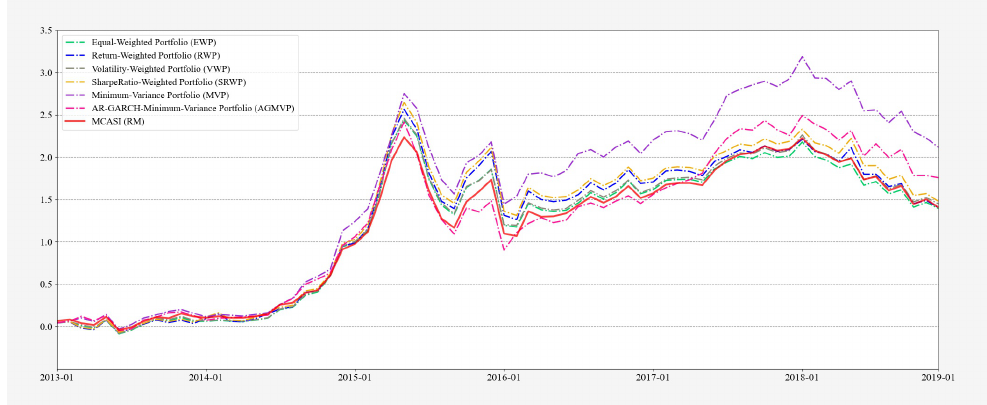
Figure 5. Various types of portfolios for sector return. Notes: Figure 5 introduces the cumulative returns of various types of portfolios for sector return. These portfolios are described in the text, including MCASI (RM), equal-weighted portfolio (EWP), return-weighted portfolio (RWP), volatility-weighted portfolio (VWP), Sharpe ratio-weighted (SRWP), minimum-variance portfolio (MVP), and AR-GARCH-minimum-variance portfolio (AGMVP). The observation period of six portfolios is from January 2013 to December 2018 considering that we used the previous 36 data to compute related